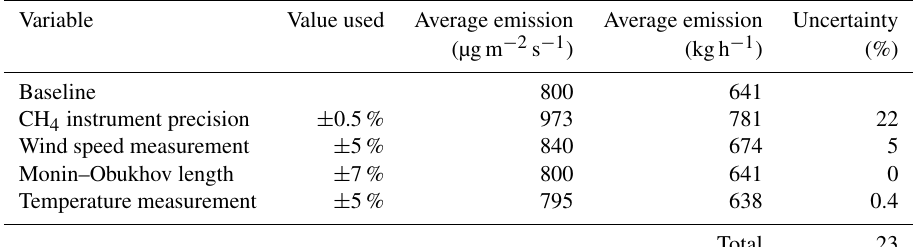
Table 3. Uncertainty analysis conducted on the case study (June 2015) for methane emission from the landfill at the Waterbeach Waste Management Park as calculated within the Gaussian plume modelling approach.